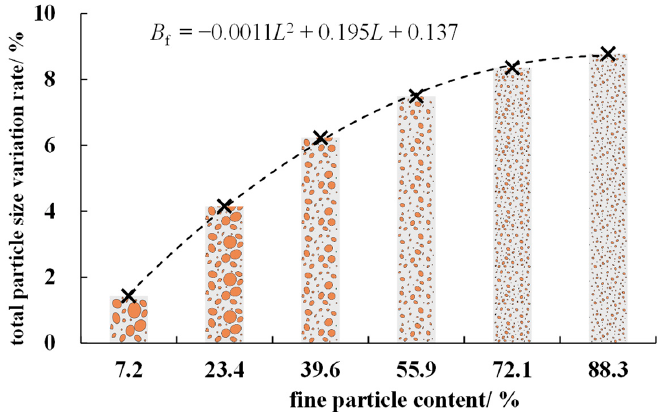
Figure 20. The effect of fine content on the total particle size.